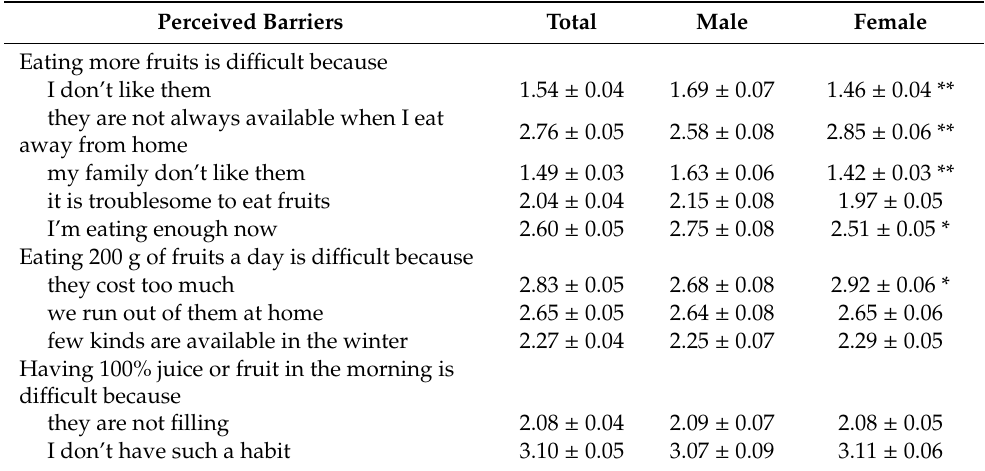
Table 4. Mean scores of perceived barriers to fruit